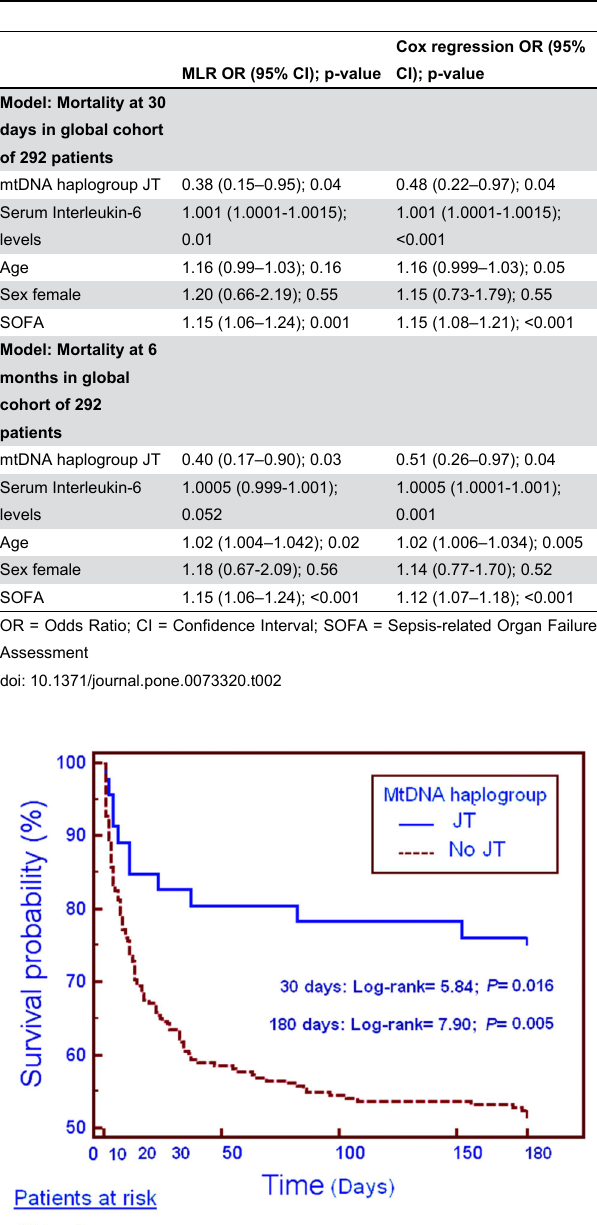
Table 2. Multiple logistic regression (MLR) and Cox regression analyses to predict mortality in the 292 patients of global cohort (first and second cohort combined).